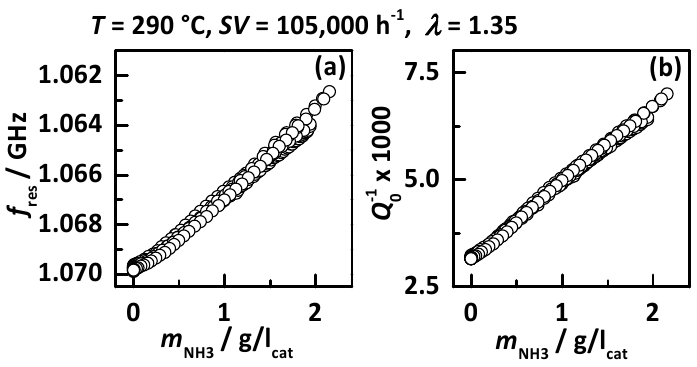
Figure 4. RF signal of experiment of Figure 3 at 290 °C with SV = 105,000 h − 1 and λ = 1.35: ( a ) the resonance frequency f res in reverse scale and ( b ) the reciprocal unloaded quality factor Q 0 − 1 as a function of the calculated stored NH 3 on the catalyst.